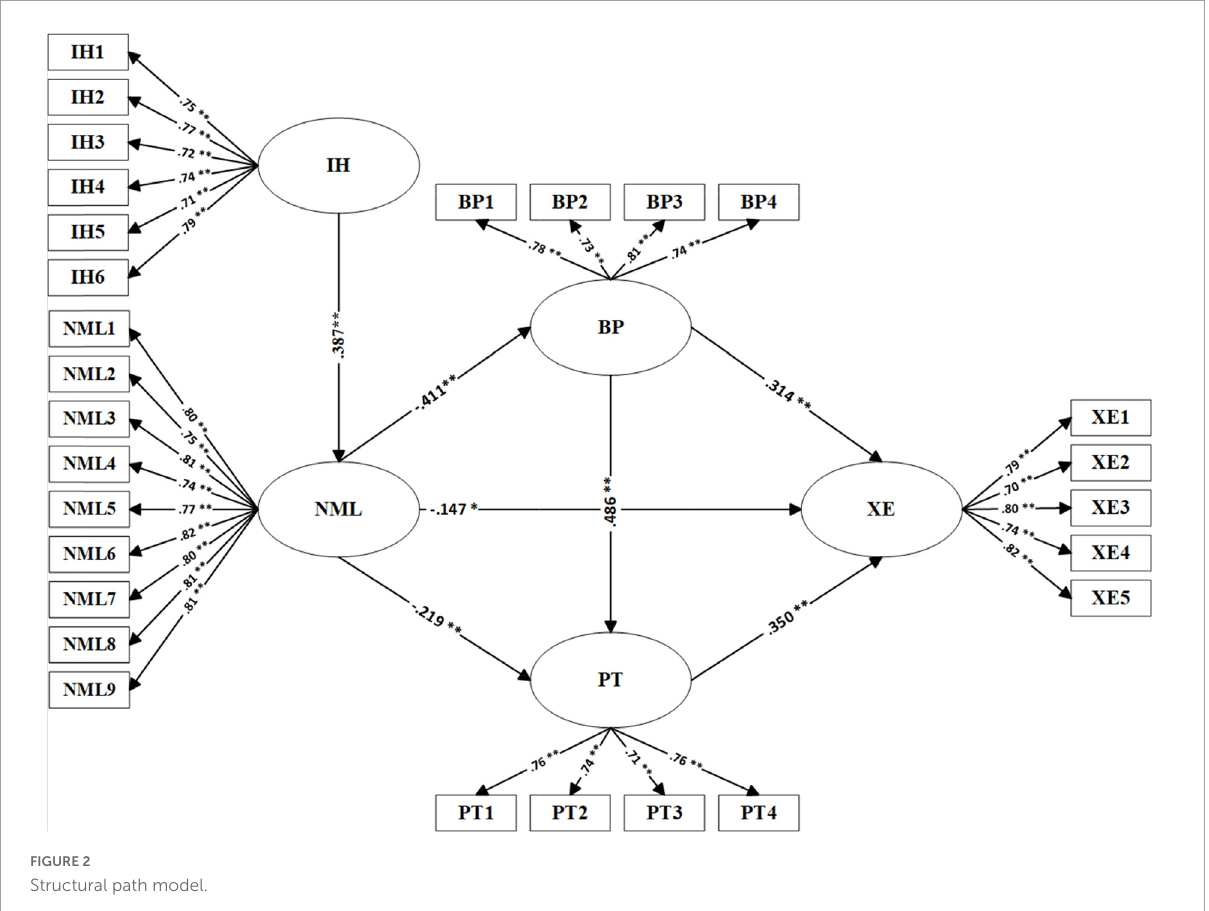
FIGURE2 Structural path model.